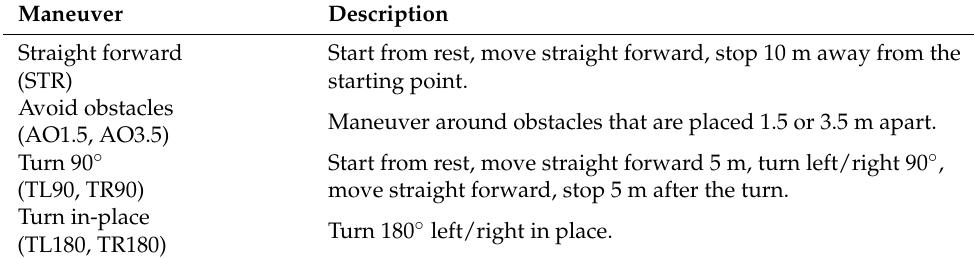
Figure 2. Wheelchair maneuvers—( Left ) (top to bottom): (1) straight forward; (2) maneuvering around obstacles placed 1.5 m apart; (3) maneuvering around obstacles placed 3.5 m apart; ( Right ) (top to bottom): (4, 5) straight forward with a 90° left/right turn; (6, 7) turning 180° left/right in place. Each maneuver was repeated 12 times. Table 4. Wheelchair maneuvers.